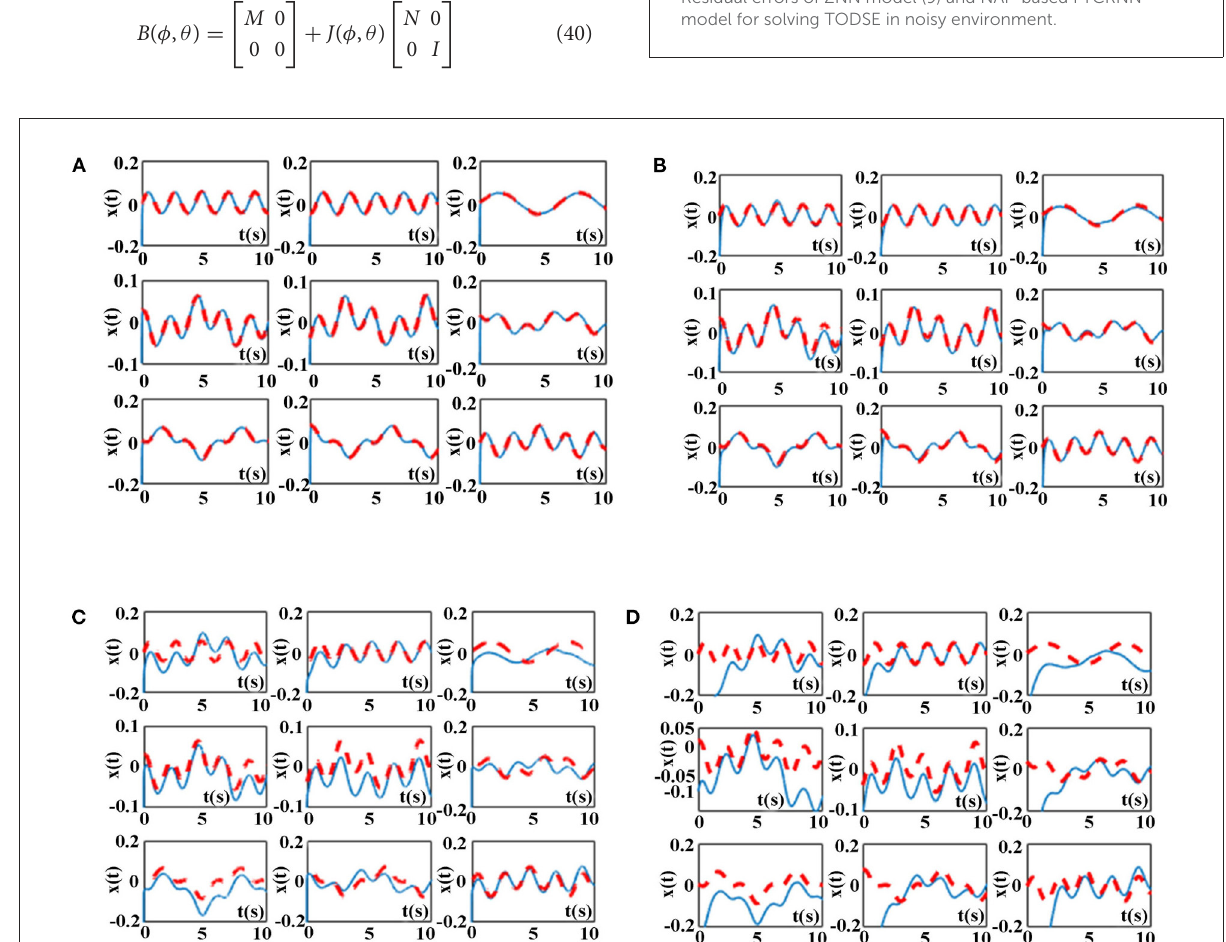
FIGURE14 TODSE (5) solved by ZNN model (9) and the proposed NAF-based FTCRNN model (12) in noisy environment. (A) Solved by FTCRNN model (12) in noisy environment (B) Solved by VAF-based ZNN model (9) in noisy environment. (C) Solved by SBPAF-based ZNN model (9) in noisy environment (D) Solved by LAF-based ZNN model (9) in noisy